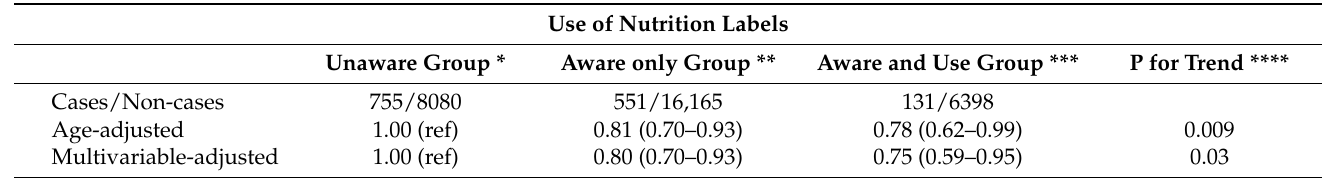
Table 2. Multivariable-adjusted $ odds ratio (95% confidence intervals) of overall CKD by use of nutrition